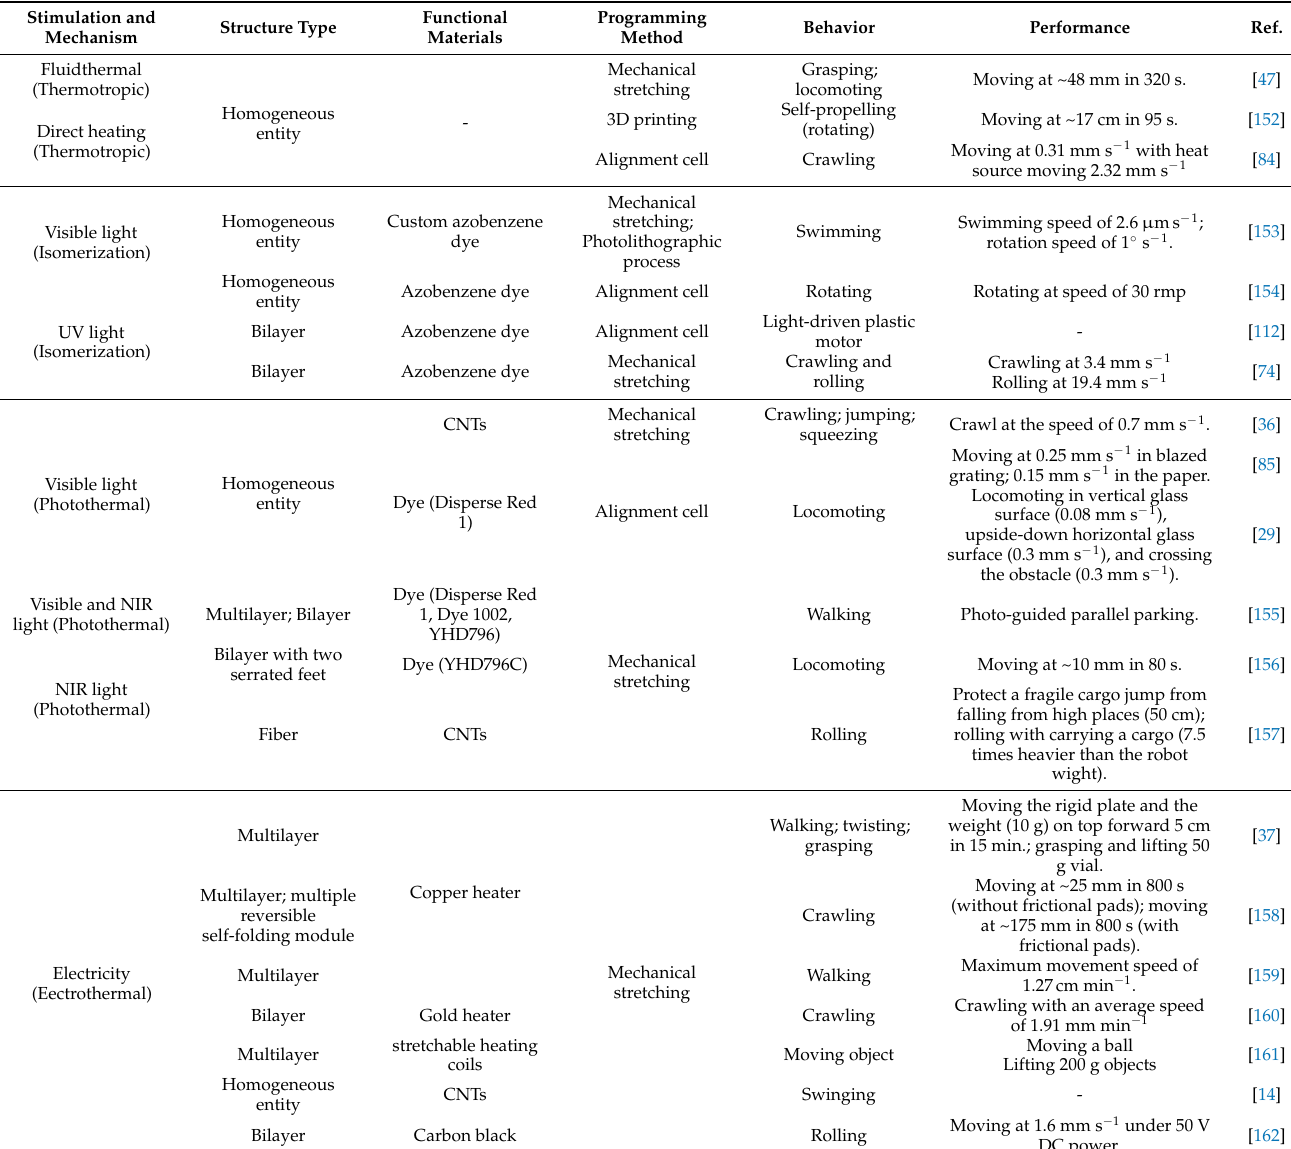
Table 2. Various LCE-based moving robots and their